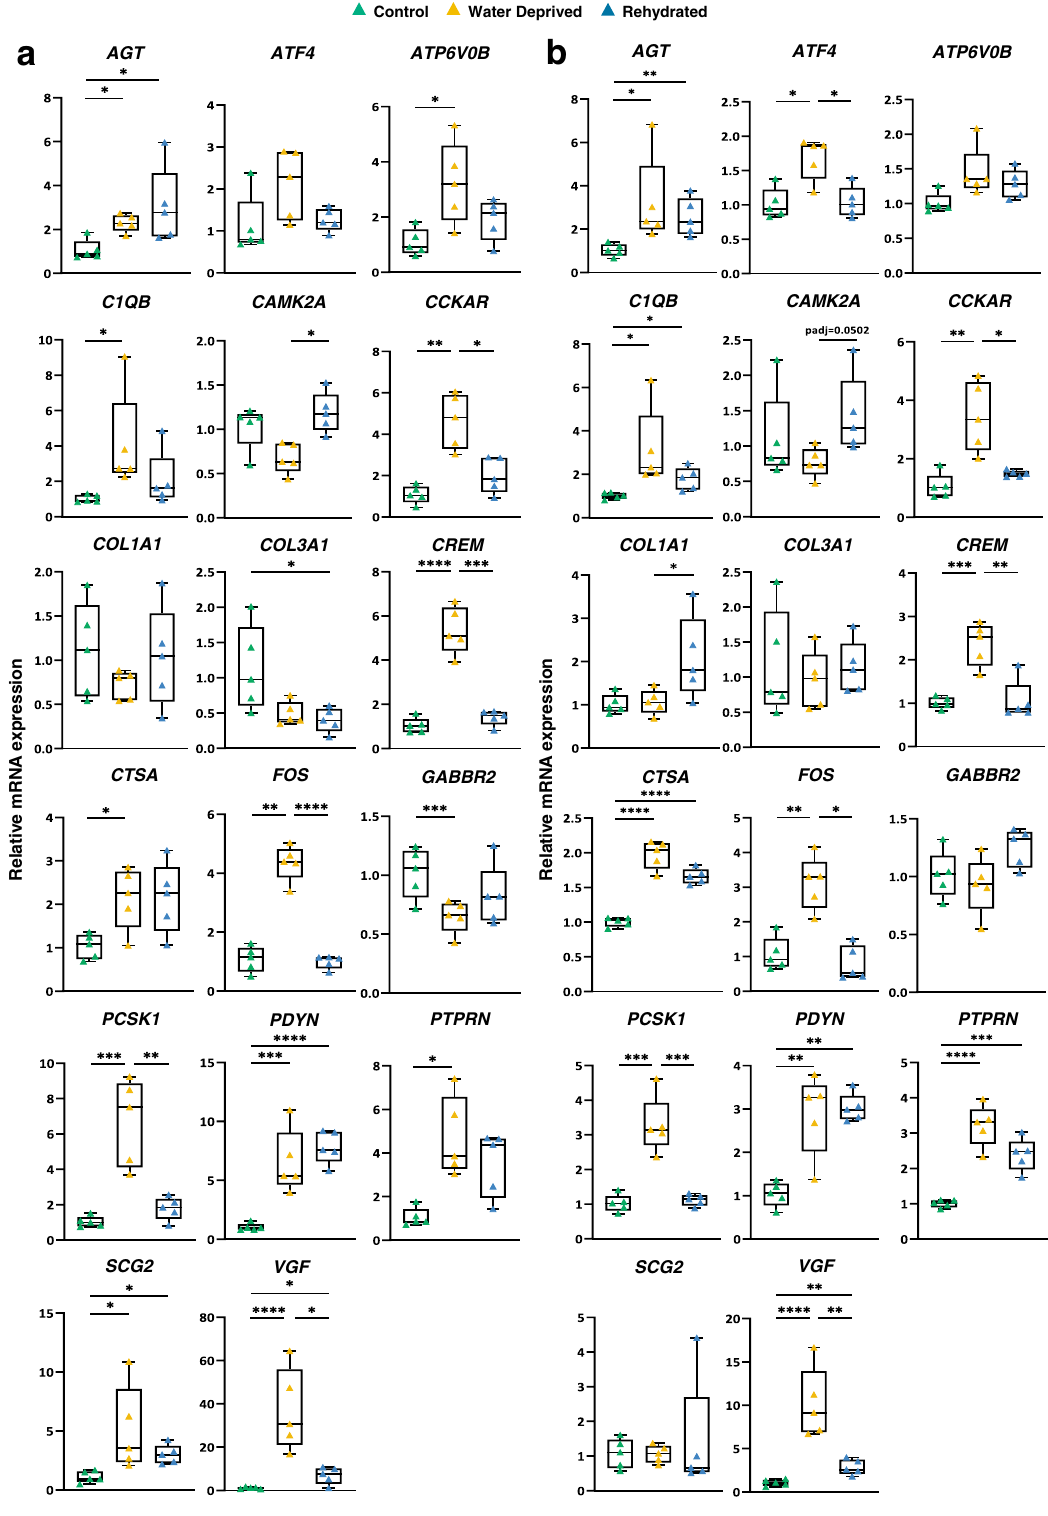
Fig. 5 qRT-PCR validation of genes changed by WD and effects of rehydration in camel SON. Differentially expressed genes in WD camel SONs ( AGT, ATF4, ATP6V0B, C1QB, CAMK2A, CCKAR, COL1A1, COL3A1, CREM, CTSA, FOS, GABBR2, PCSK1, PDYN, PTPRN, SCG2 and VGF ) identi fi ed by RNAseq and subjected to qRT-PCR validation. Expression of these genes in both rostral ( a ) and caudal ( b ) SONs. Results (listed in alphabetical order) are illustrated by box and whisker plots with each individual value shown as a superimposed triangle (control: green; WD: yellow; rehydrated: blue). Whiskers represent the minimum and maximum values within a group. The median is shown as a line in the centre of the box. Data was analysed by using Brown-Forsythe and Welch one-way ANOVA with Dunnett T3 post-hoc test. *padj ≤ 0.05, **padj ≤ 0.01, ***padj ≤ 0.001, ****padj ≤